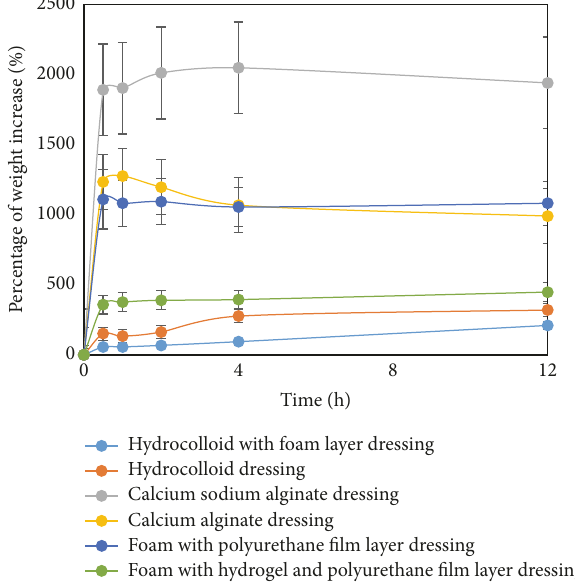
Figure 2: Absorption